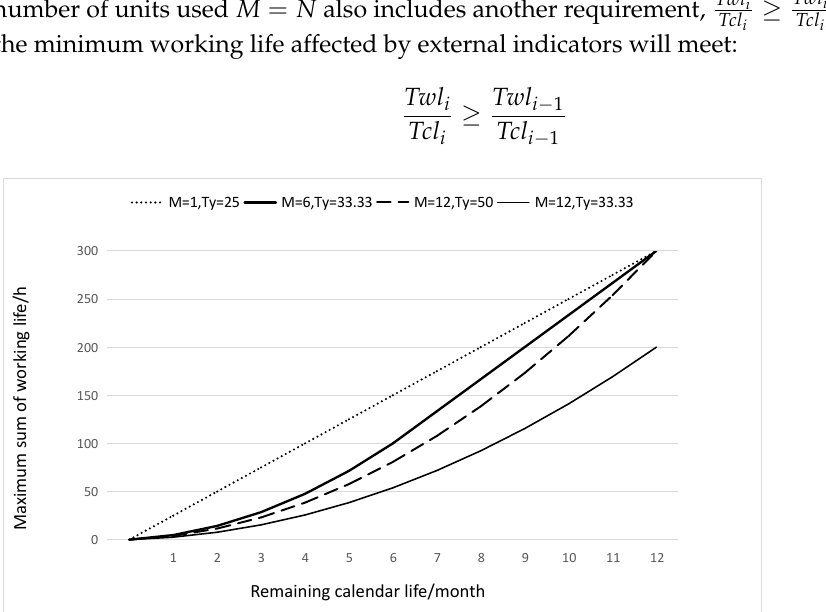
Figure 5. Maximum sum of working life. It can be seen that under the same working life and conditions, the greater the num- ber of units used, the more limited they become. So, set